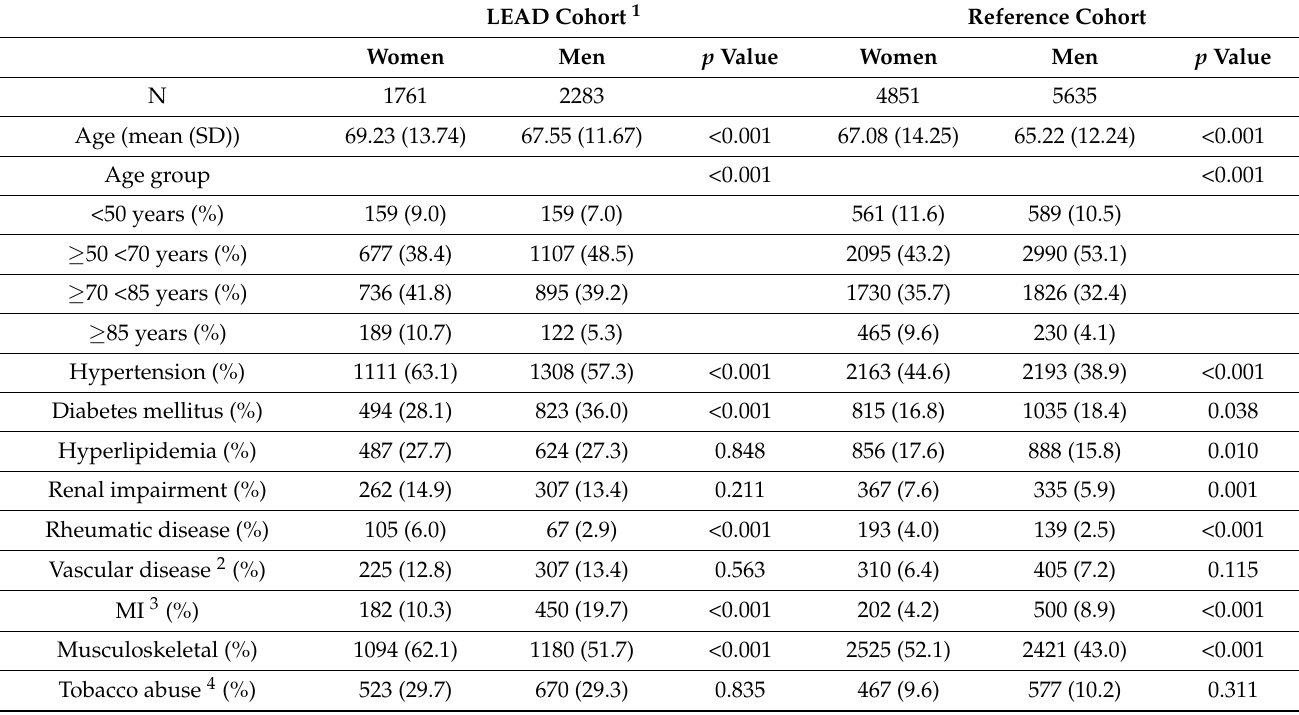
Table 1. Baseline